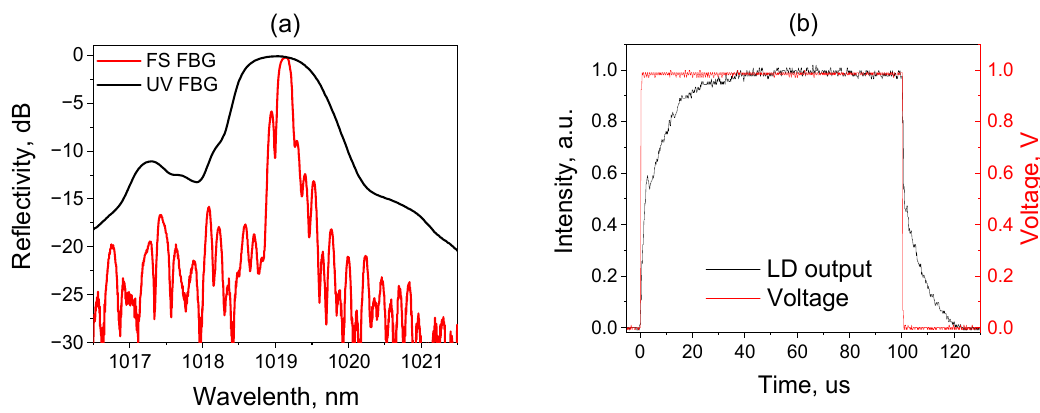
Figure 2. Reflection spectra of OC UV FBG and HR fs-inscribed FBG ( a ) and laser diode pump pulses and control electric square waveform signal used for gain modulation ( b ).